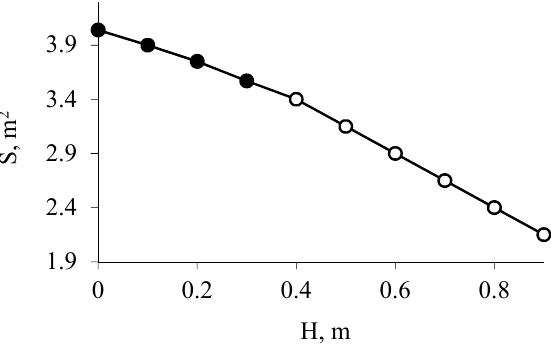
Fig. 1. Dependence of the area of evaporation surface on the height of the liquid in the